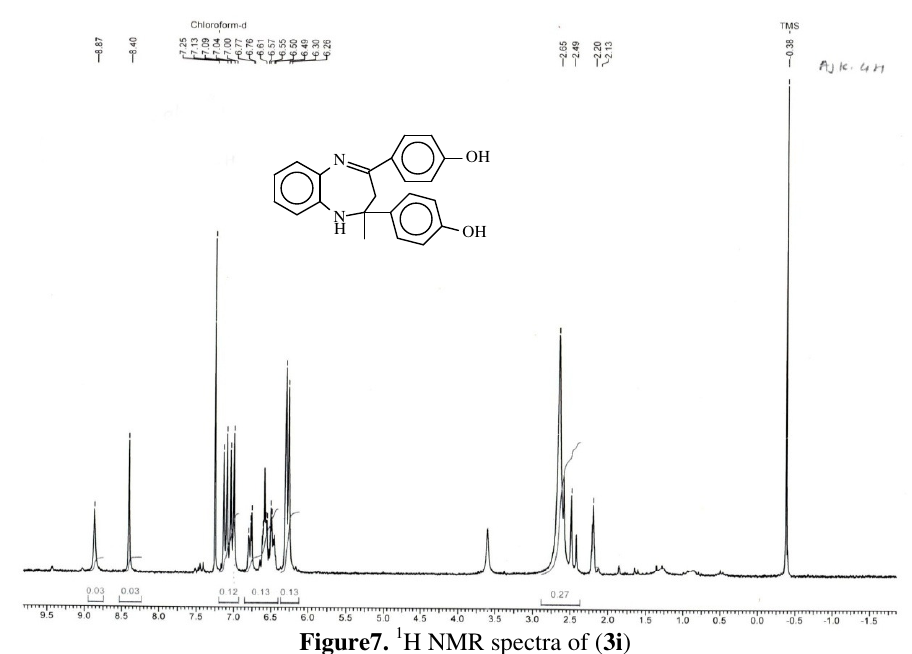
Figure7. 1 H NMR spectra of ( 3i